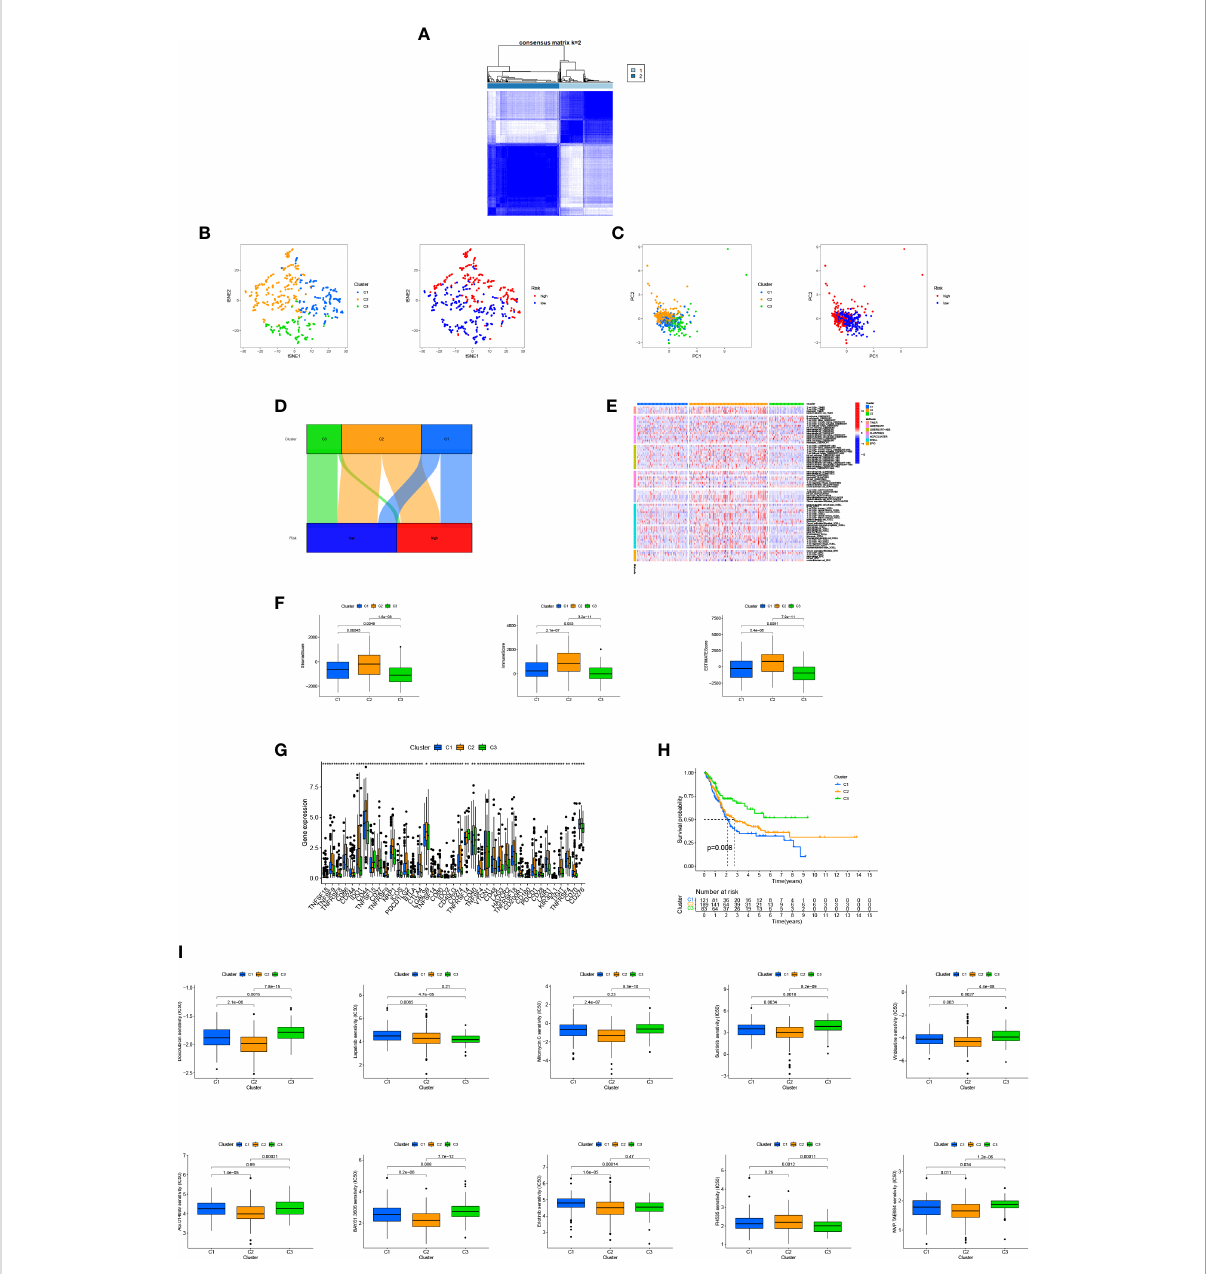
FIGURE 8 TME differences and underlying immunotherapy of different subtypes of bladder cancer: (A) Division of bladder cancer into three subtypes; (B, C) The t-SNE and PCA analysis of different subtypes; (D) Sankey diagram of interrelationship between three subtypes and high- and low- risks; (E) Heat map of immunocyte-related analysis of subtypes; (F) Differences in immune microenvironment scores of different subtypes; (G) Histogram of immune checkpoint expression differences between subtypes; (H) OS analysis curves of patients with different subtypes of bladder cancer; (I) cluster 2 drug sensitivity analysis. **p < 0.01, *p <